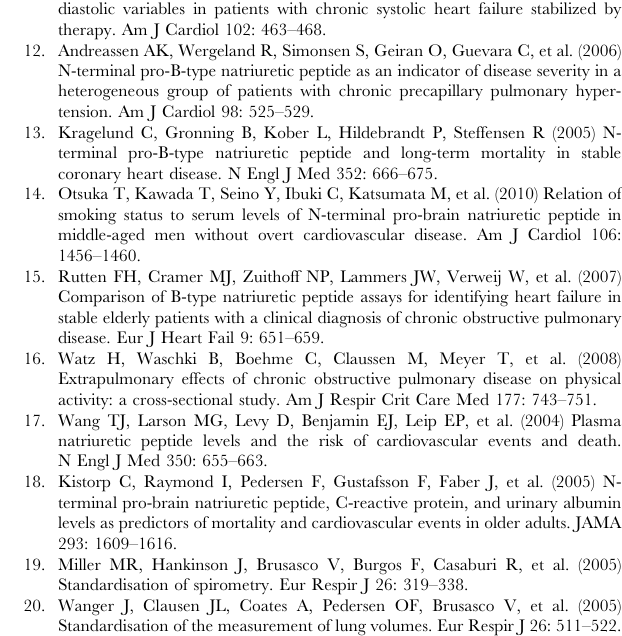
Table S1 Correlation analysis between NT-proBNP and demographics, lung function and renal function* (correlation coefficient, significance value). (DOC) Table S2 Survival Rates at Specific Follow Up Intervals. Survival rates are listed as percent survival (95% CI) for all subjects (All) and as dichotomized around the median NT-proBNP value (49 pg/mL) (High and Low NT-proBNP). (DOC) Table S3 Overall mortality by tertiles of NT-proBNP. Median (IQR) within each tertile of NT-proBNP and corresponding overall mortality rate. (DOC) Table S4 Univariate proportional hazard mortality analysis across increasing tertiles of NT-proBNP. (DOC) Table S5 Multivariate proportional hazard mortality analysis across increasing tertiles of NT-proBNP.